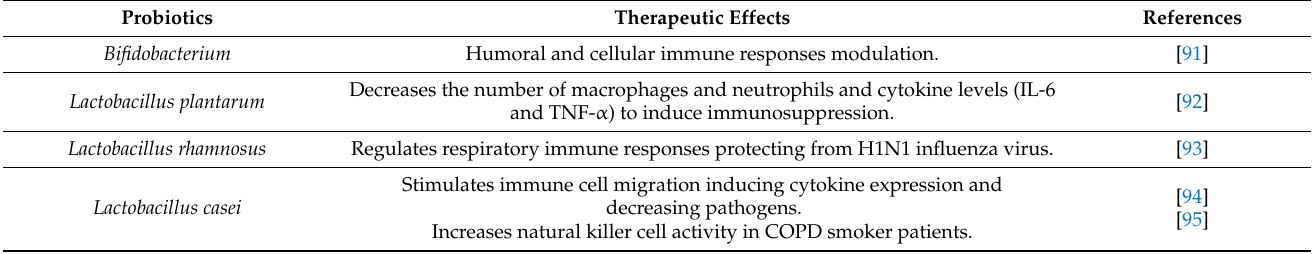
Table 2. The therapeutic effects of probiotics.